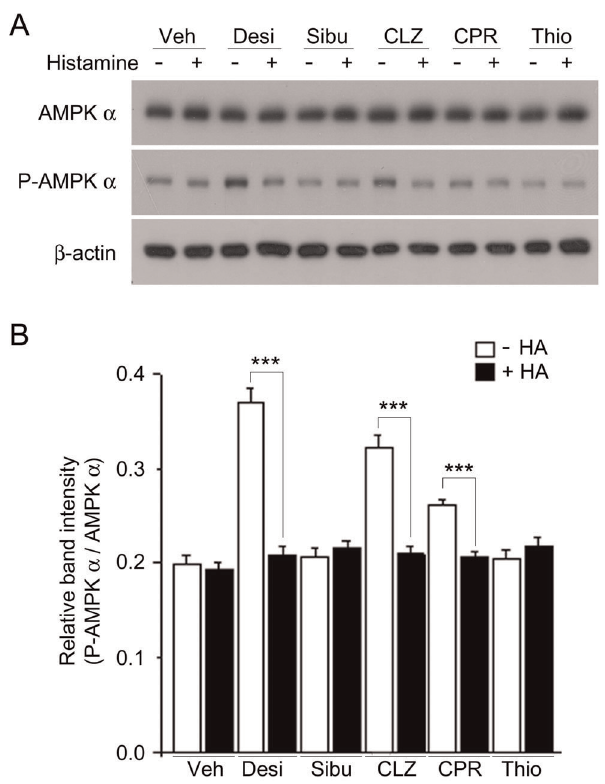
Figure 6. Desipramine, but not sibutramine, inhibits the phosphorylation of AMPK a . (A) Cells were pretreated with vehicle (Veh), 10 m M desipramine (Desi), 3 m M sibutramine (Sibu), 100 nM clozapine (CLZ), 1 m M chlorpheniramine (CPR), or 1 m M thioperamide (Thio), with or without histamine (100 m M) treatment and, proteins were subjected to immunoblotting using anti-AMPK a , anti-phospho- AMPK a and anti- b -actin, as indicated. Anti-AMPK a and anti- b -actin were used to probe for equal protein loading. The plus and minus symbols indicate the presence or absence of Histamine (HA). (B) Relative band intensity of was determined by densitometric analysis of (A). The results shown are the means 6 SEM of four independent experiments. ***P ,